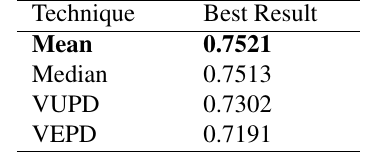
Table 7. Stage 2. Results obtained with the preprocessing tech-